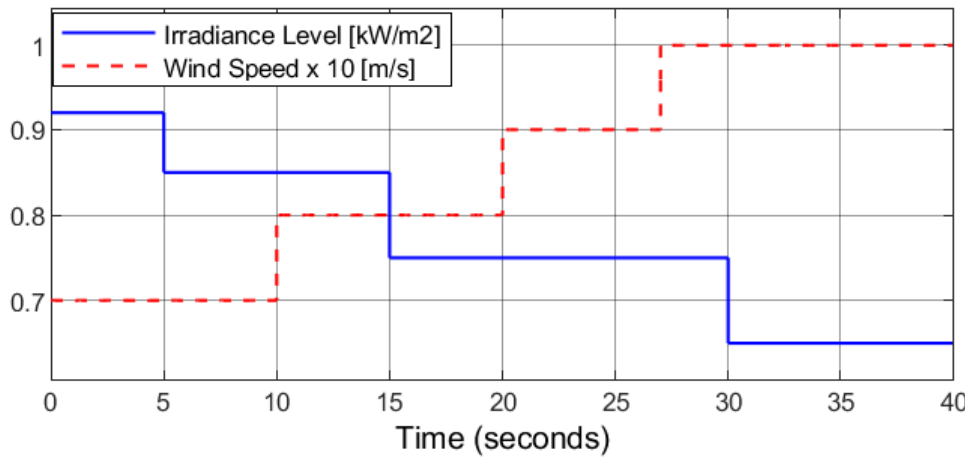
Figure 10. Scenario 3: irradiance level and wind speed.